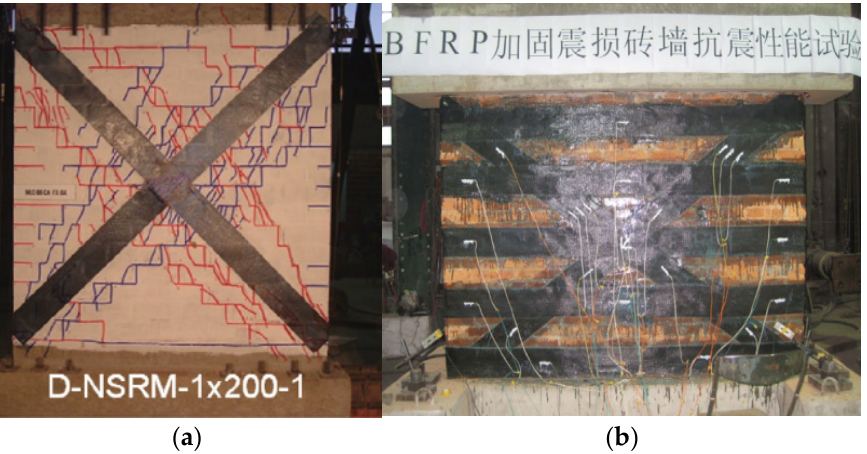
Figure 3. Specimens strengthened by: ( a ) CFRP strips [30]. Reproduced with permission from Santa-Maria, H., Alcaino, P. Repair of in-plane shear damaged masonry walls with external FRP; published by Elsevier, Construction and Building Materials, 2010. ( b ) BFRP stripes [31]. Reproduced with permission from Zhou, D.; Lei, Z.; Wang, J. In-plane behavior of seismically damaged masonry walls repaired with external BFRP; published by Elsevier, Composite Structures, 2013.